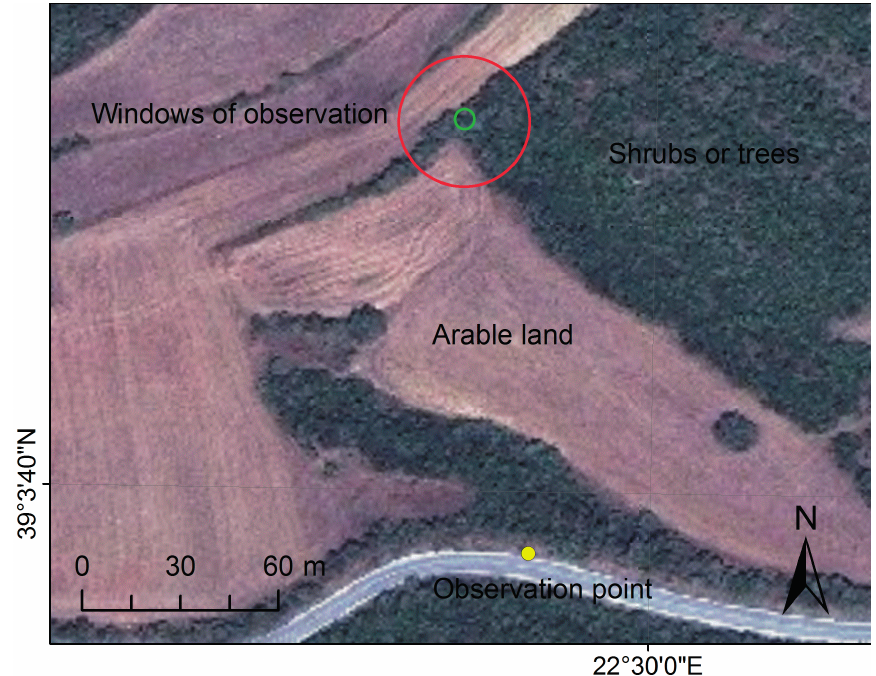
Figure 16. A paradox case in Larisa, where a mixture of agricultural land with an extended shrubland surface is not possible to be identified, neither by using the 3-m radius (small green circle) nor the 20-m radius (big red circle) observation